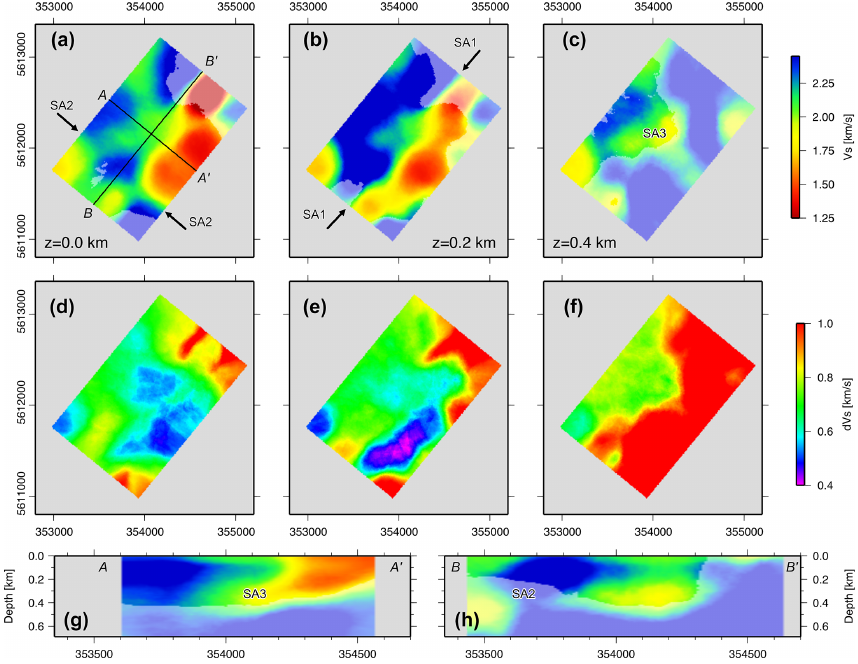
Figure 9. Slices through the final three-dimensional shear velocity model. (a–c) S-wave velocity, (d–f) its uncertainty at the surface, and at depths of 200 and 400m, respectively. (g–h) Vertical slices through the velocity model in NW–SE (AA (cid:48) ) and SW–NE (BB (cid:48) ) directions, respectively. Regions with low colour saturation indicate a high velocity uncertainty (above 0.8kms − 1 ). Labels SA1, SA2 and SA3 mark velocity anomalies described in the